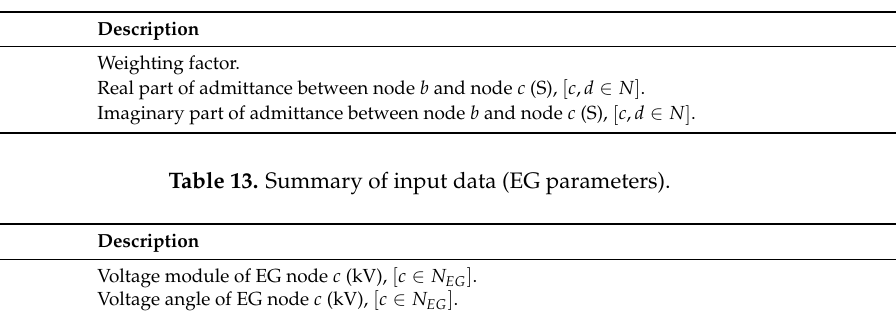
Table 12. Summary of input data (constants and general parameters).